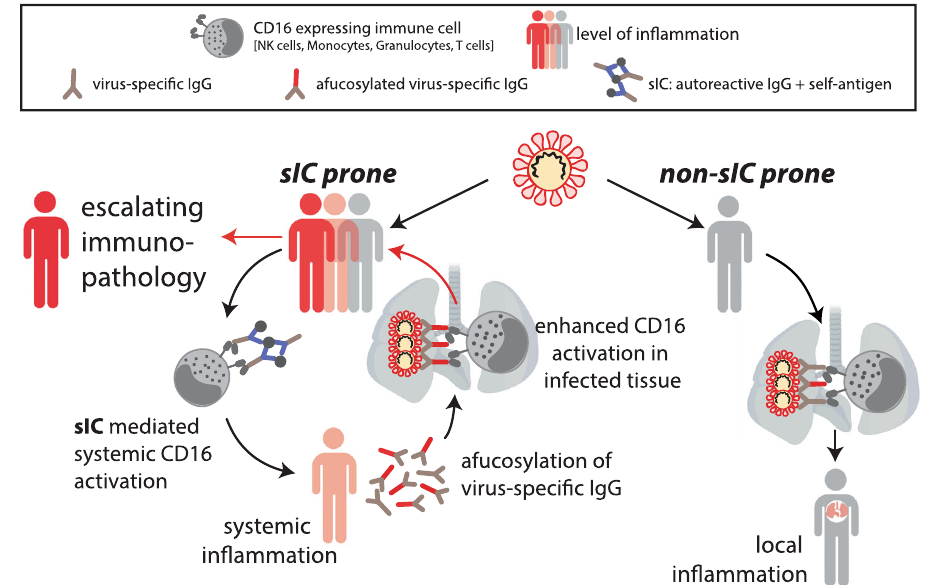
Fig. 6 | Model proposing a vicious cycle of immunopathology in COVID-19 patients driven by soluble multimeric immune complexes (sICs). SARS-CoV-2 infection triggers innate responses leading to autoreactive sIC formation in prone individuals. Activation of Fc γ RIIIA/CD16A expressing immune cells (NK cells, monocytes, T cells, granulocytes) by systemically emerging sICs leads to systemic in fl ammation. sIC-driven systemic in fl ammation, tissue in fl ammation mediated